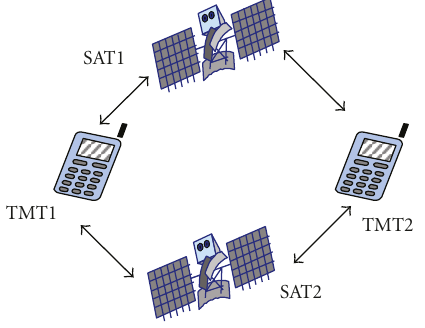
Figure 1: A virtual array: 2 satellites and 2